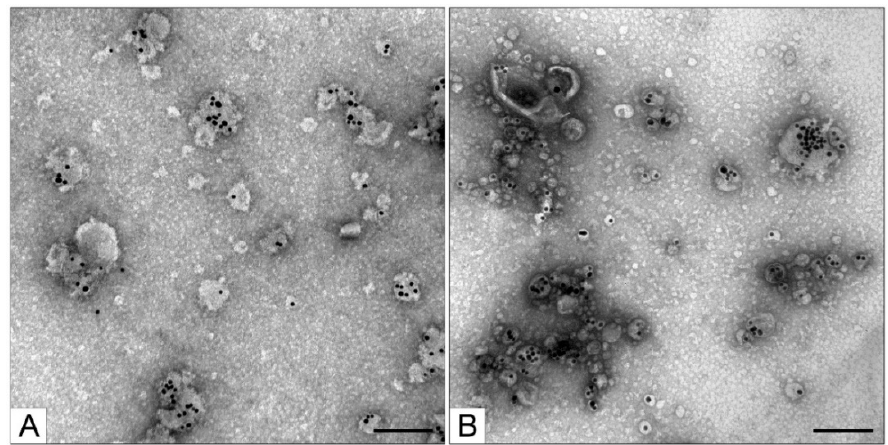
Figure 6. Ultrastructure of the MLNCs prepared from the lipid film synthesized under a pressure of 12 mmHg ( A ) or 6 mmHg ( B ). The scale bars correspond to 200 nm. Negative staining with a 0.5% uranyl acetate solution followed by TEM.